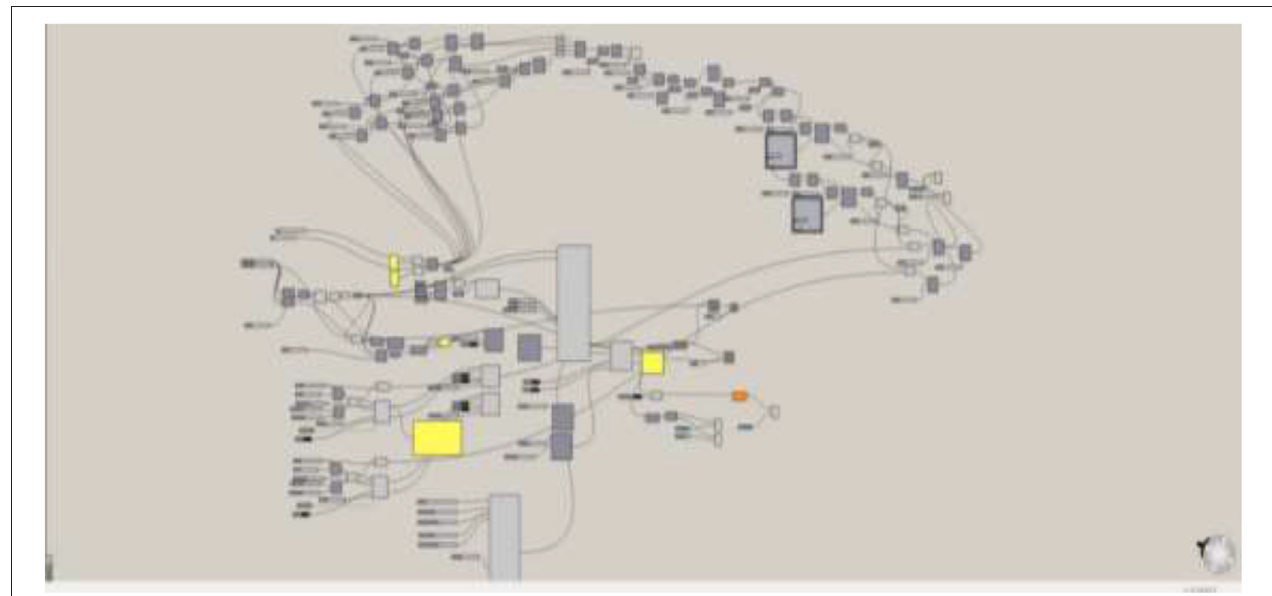
FIGURE 12 | Written scripts through grasshopper for writing to environment and reading from